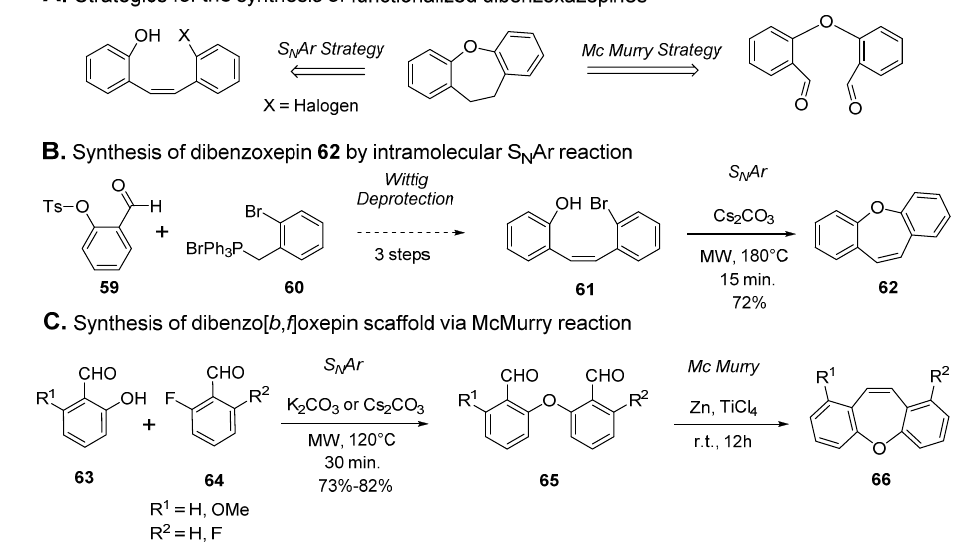
Figure 5. Relevant examples of bioactive dibenz[ b , f ]oxepines.